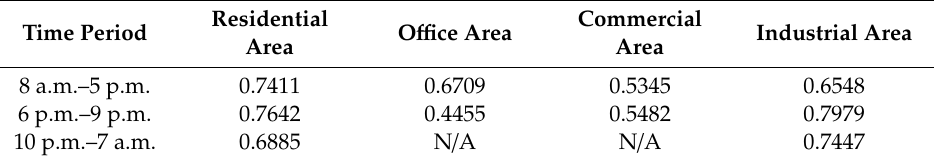
Table 4. Correlation coe ffi cients between the output of renewable energy and the charging power of EVs in each functional area.